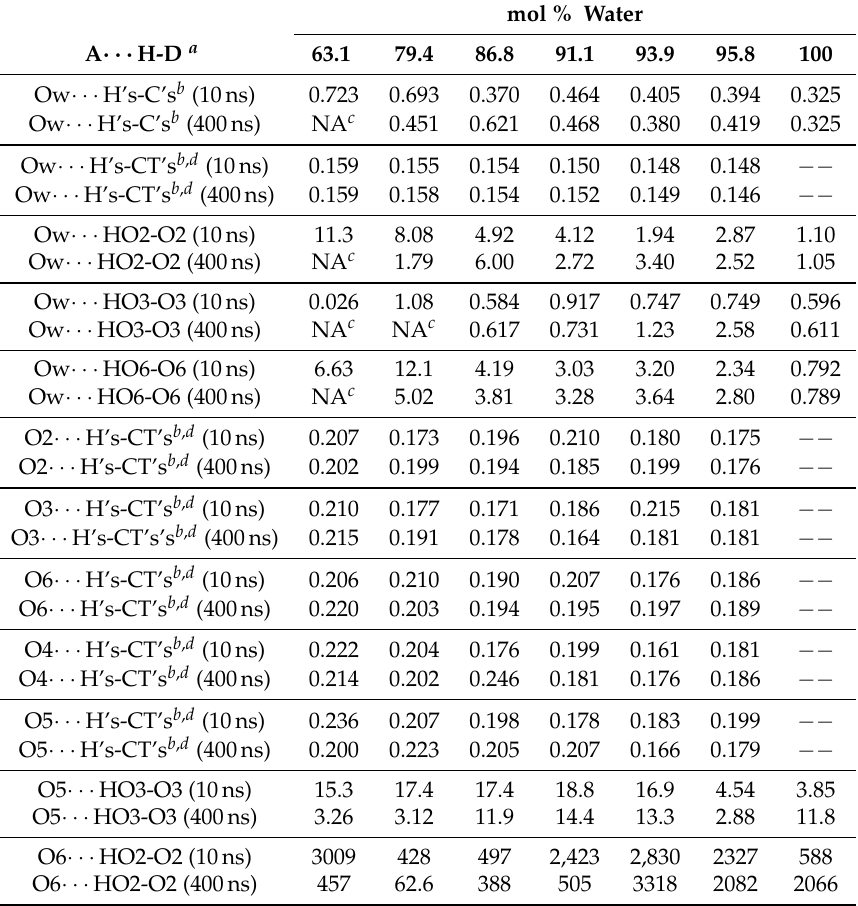
Table 4. TBPCl hydrogen bonding lifetimes (ps), Part 2 of